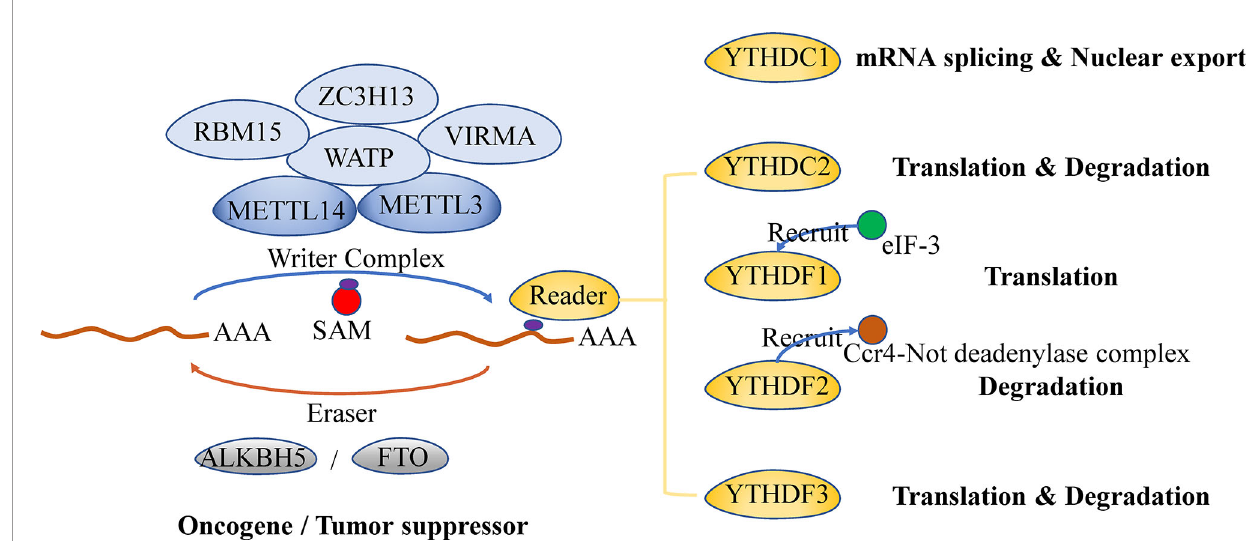
FIGURE 1 | Regulator of m 6 A modi fi cation on mRNA and its biological